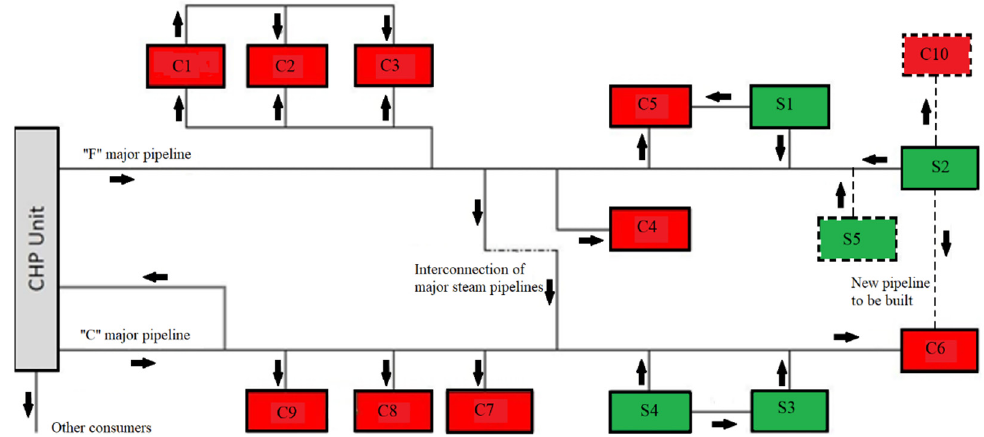
Figure 3. A part of simplified simulation scheme of HPS network after implementation of proposed changes (S = steam supplier, C = steam consumer; existing connection of main pipelines = dot-dashed line, new connection of pipelines = dashed